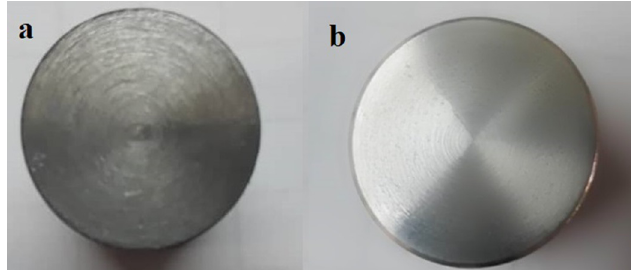
Fig. 3. Surface quality of steel 316LVM sample (a) Initial state, (b) After MAF process.